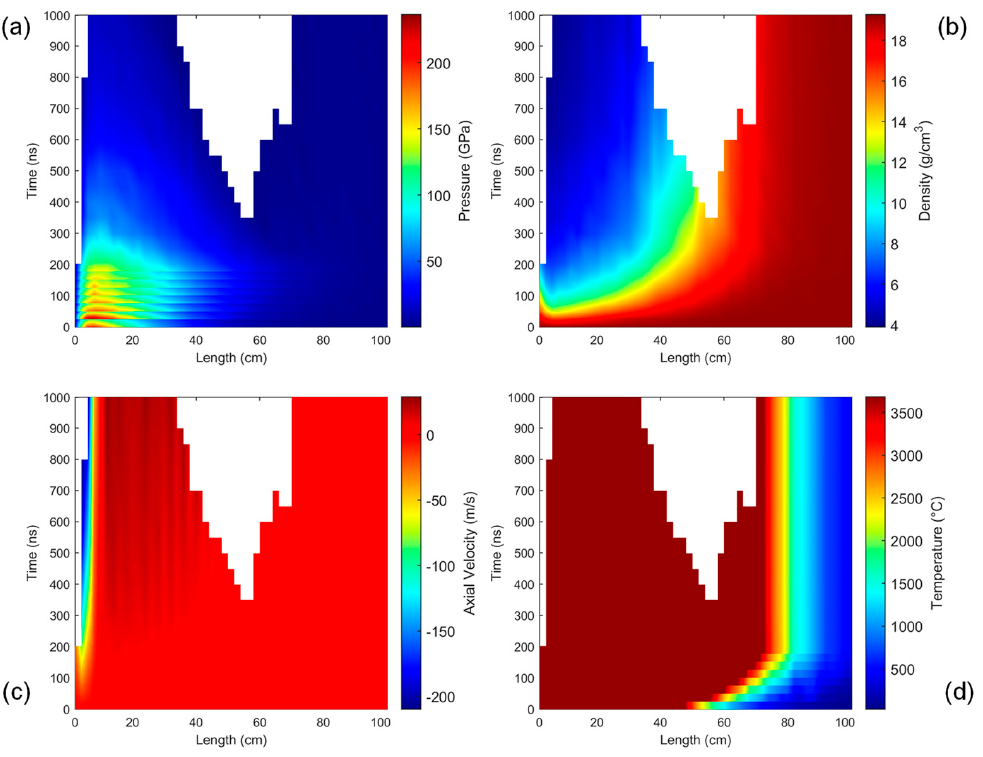
Figure 11. Pressure ( a ), density ( b ), particle velocity in axial direction ( c ), and temperature ( d ) distributions as a function of the length at R = 0 mm (axis of symmetry) (R 0 of Figure 5).